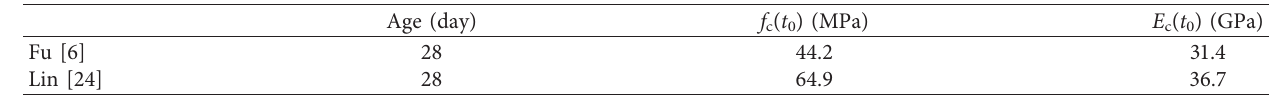
Table 3: Material parameters of concrete.